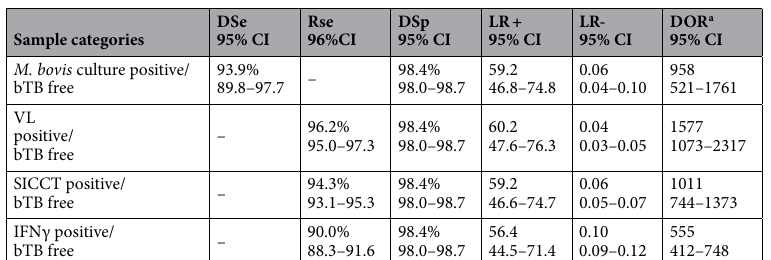
Table 7. Likelihood ratio (LR) for positive (LR +) and negative (LR−) boosted serum samples at the high sensitivity setting. a DOR - diagnostic odds ratio.